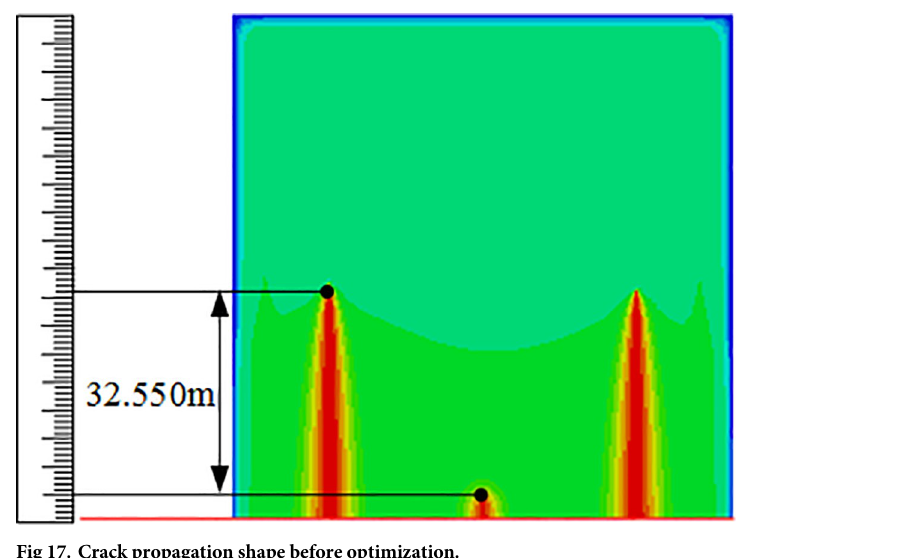
Fig 17. Crack propagation shape before optimization.